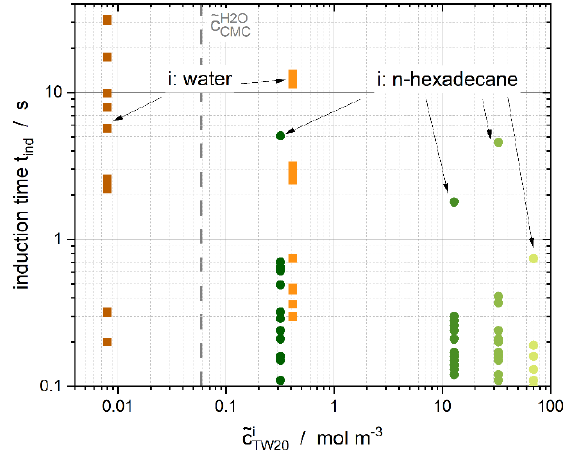
Figure 13. Induction time t ind , defined as the delay between nucleation and the first visible contact between the droplet and particle, as a function of surfactant concentration in either dispersed or continuous phase for relative velocities ranging from 6 × 10 − 6 up to 4 × 10 − 3 m s − 1